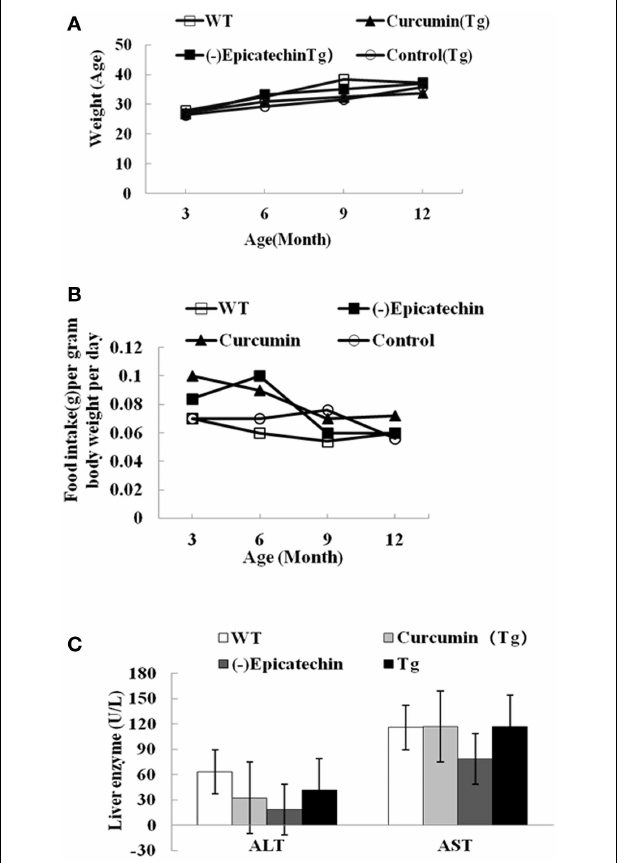
FIGURE 1 | ( − )Epicatechin is well tolerated inAPP/PS1 transgenic mice . APP/PS1 transgenic mice were fed control, curcumin or ( − )epicatechin diets for 9months from 3months of age. In parallel, wild-type littermates were fed with control diet too. (A) Body weight was measured at 3, 6, 9, and 12months of age. (B) Food intake was monitored at 3, 6, 9, and 12months of age, and was calculated as food intake (gram) per gram body weight per day. (C) Serum indices of liver functional status such as AST and ALT. Points and bar graphs represent group mean ( ± SEM).